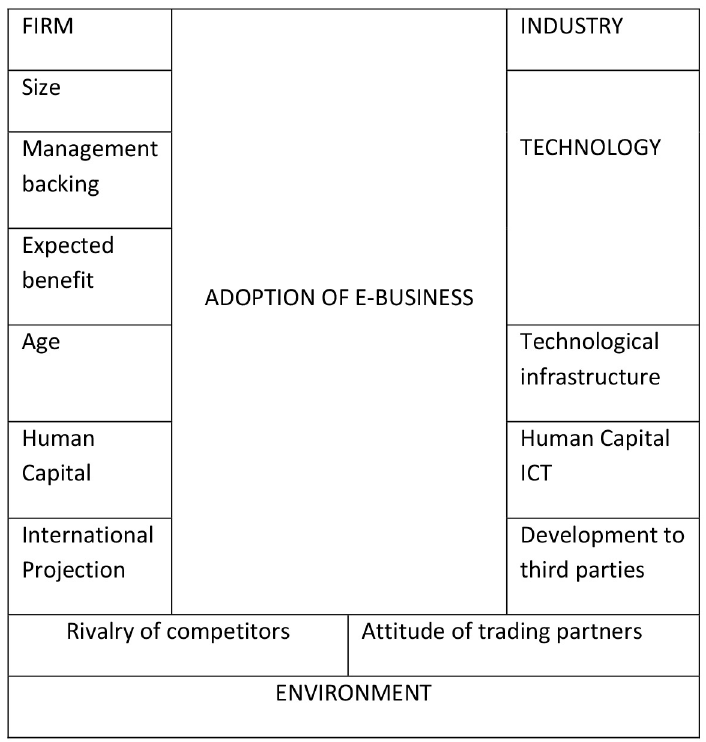
Figure 1. Model of successful adoption of e-business practices (Author’s own